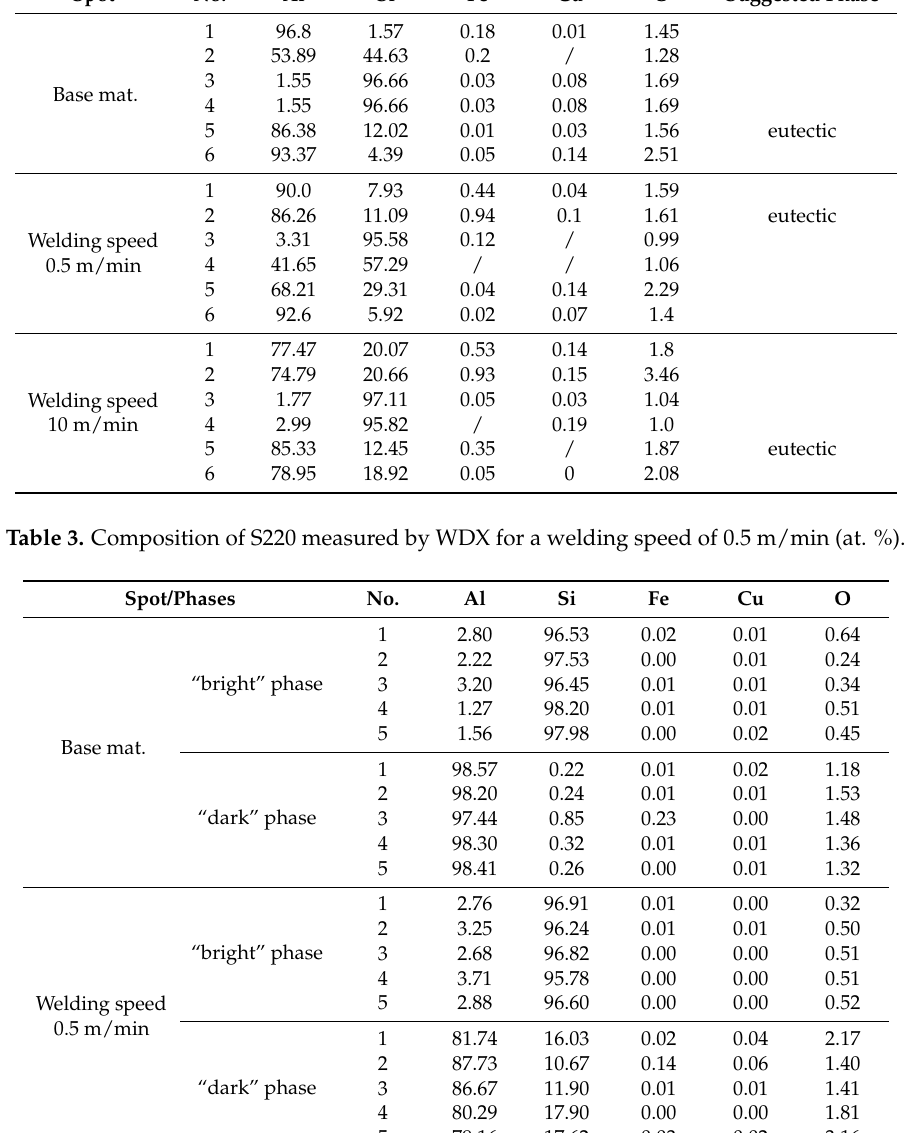
Table 2. Composition of S220 measured using EDX for a welding speed of 0.5 m/min (at. %). Spot No. Al Si Fe Cu O Suggested Phase 1 96.8 1.57 0.18 0.01 53.89 Base mat.